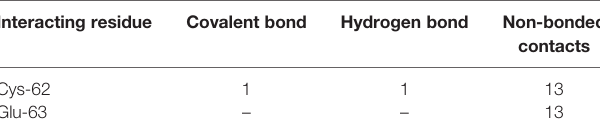
FIGURE 4 | Covalent docking of andrographolide to human NFkB1. (A) NFkB1 is shown in surface representation colored light orange with bound native double- helical DNA and docked andrographolide. The docked andrographolide forming Cys-andrographolide adduct was shown as a close-up in the inset. The andrographolide, part of the adduct, was shown in sticks representation having carbon backbone in green color with heteroatoms oxygen, nitrogen, sulfur, and hydrogen atoms in red, blue, yellow, and white colors respectively. The Cys-62 part of the adduct forming the covalent bond through sulfur atom was also shown in sticks representation with the backbone in orange color. (B) Protein-ligand interaction plot of andrographolide with NFkB1. The andrographolide and hydrogen bonding residues are shown in ball and sticks representation with balls representing atoms and sticks representing the bond between two atoms. The color of balls distinguishes among atom types as C-atom in black, O-atoms in red, N-atoms in blue, and S-atom in yellow colors. The non-bonded interactions labeled with interacting residue are shown as red arcs with bristles, covalent bonds as purple line, and hydrogen bonds as thick green lines labeled with bond length in TABLE 4 | The NFkB1 residues interacting with andrographolide.